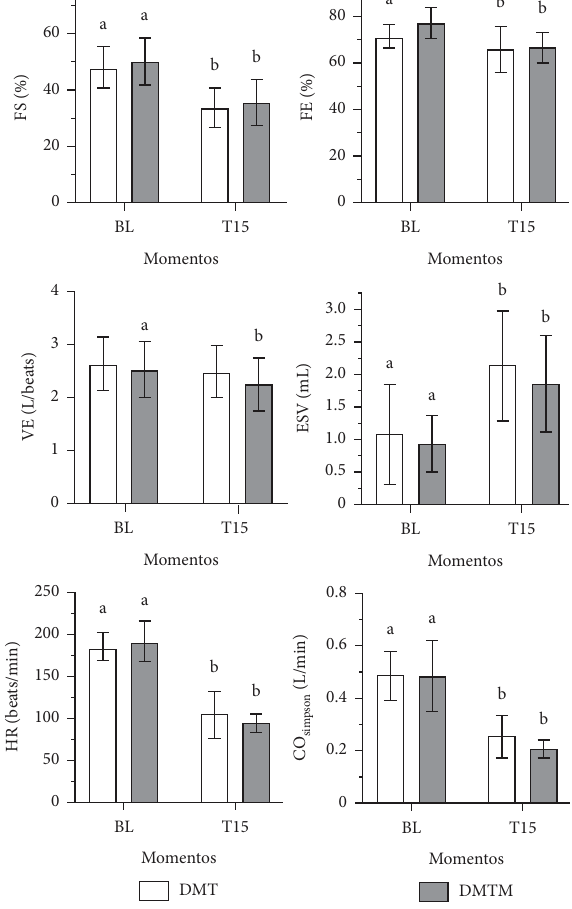
Figure 3: Values for interventricular septum in diastole (IVSd) and systole (IVSs), left ventricular posterior wall in diastole (LVPWD), and systole (LVPWS) and left ventricular internal diameter in diastole (LVIDd) and systole (LVIDs), in 18 sedated cats with the combination of dexmedetomidine (7.5ug/kg) and methadone (0.3mg/kg) (DMT, n � 9) or dexmedetomidine (5ug/kg), metha- done (0.3mg/kg), and midazolam (0.3mg/kg) (DMTM, n � 9), both by the intramuscular route. Values are presented as mean- ± standard deviation. a, b: diferent lowercase letters indicate a signifcant diference between moments within the same group according to the Tukey test ( p < 0 . 05).